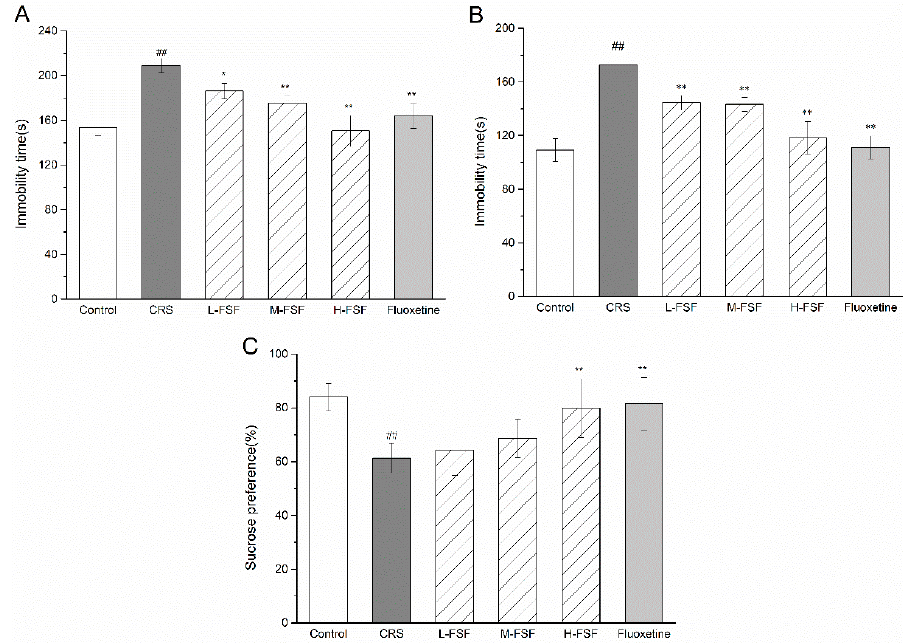
Figure 4. Effects of FSF on depressant-like behaviors in mice. ( A ) Forced swimming test. ( B ) Tail suspension test. ( C ) Sucrose preference test. n = 10, # p < 0.05, ## p < 0.01 vs. Control group; * p < 0.05, ** p < 0.01 vs. CRS treated group.